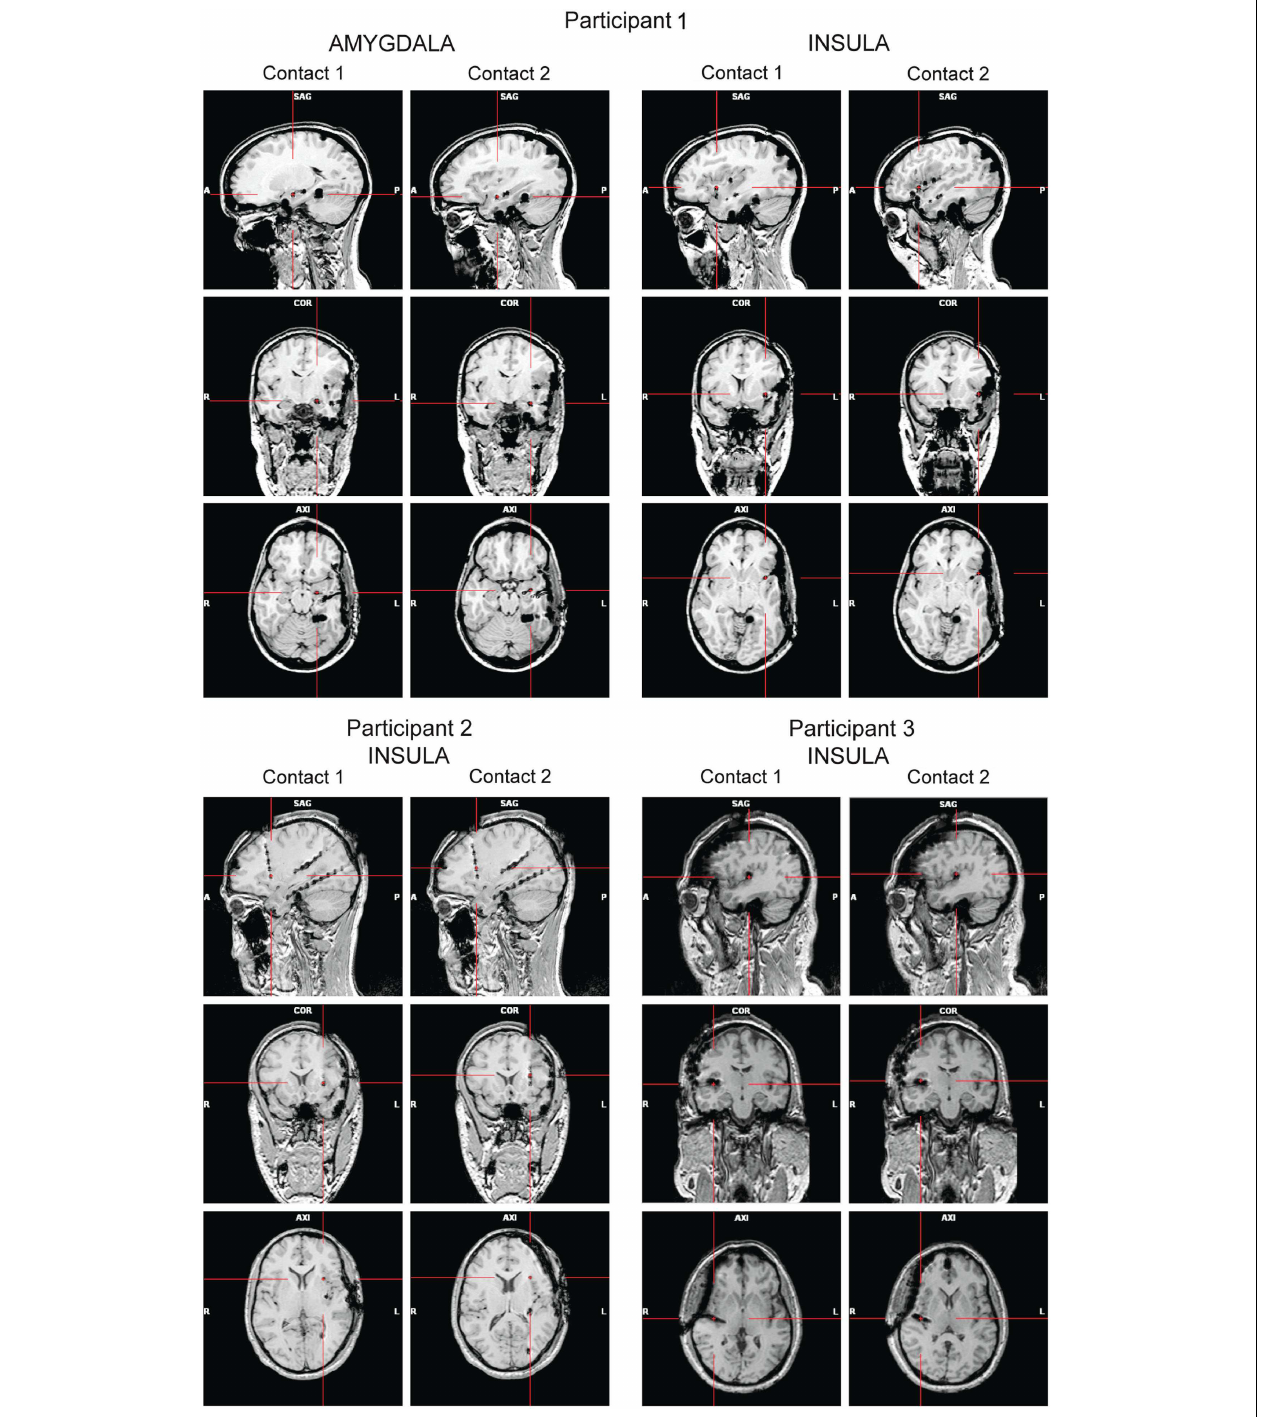
FIGURE 1 | Panels show the locations of the electrode contacts of interest for each participant based on post-implantation MRIs (A, anterior; P, posterior; L, left; R, right).